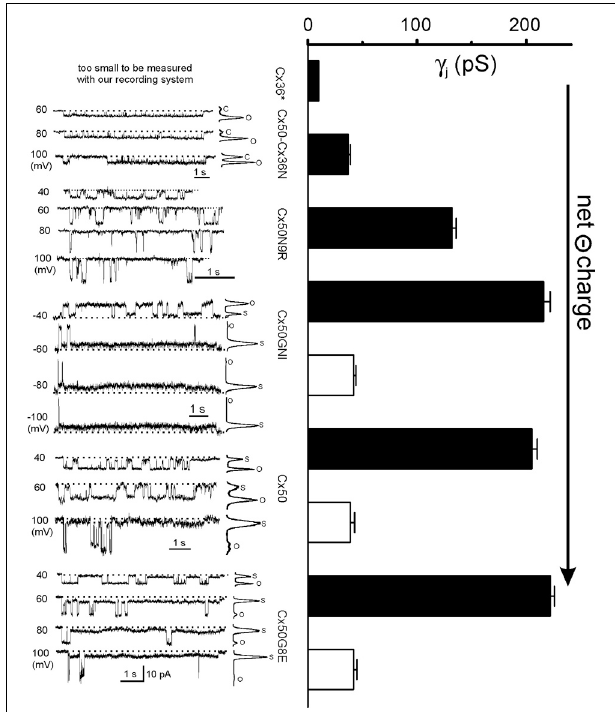
FIGURE 3 | Single channel conductance ( γ j ) of Cx36, Cx50, and Cx50 mutants. Unitary currents recorded from N2A cell pairs expressing Cx36, Cx50-Cx36N, Cx50N8R, Cx50GNI, Cx50, and Cx50G8E are shown on the Left . On the Right , the bar graph summarized the averaged single channel conductance of the main open state (black bars) and the residue state (open bars). Data for Cx36* gap junction channels are from (Srinivas et al., 1999b) and Moreno et al. (2005). The data on Cx50, Cx50-Cx36N, and Cx50N9R are from Xin et al. (2010) and the data on Cx50GNI and Cx50G8E are from Xin et al. (2012a) with